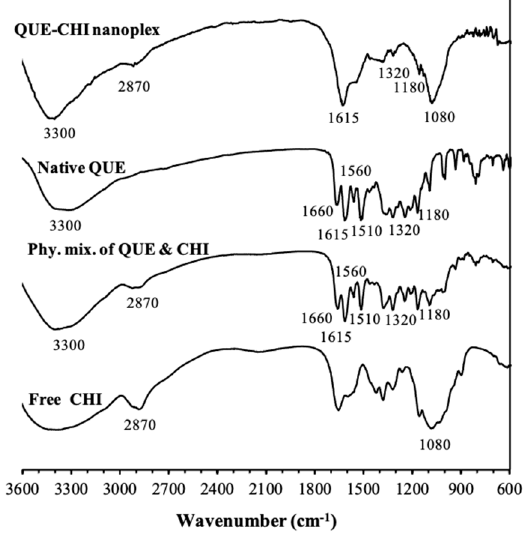
Figure 4. FTIR spectra of the QUE–CHI nanoplex and its constituents.